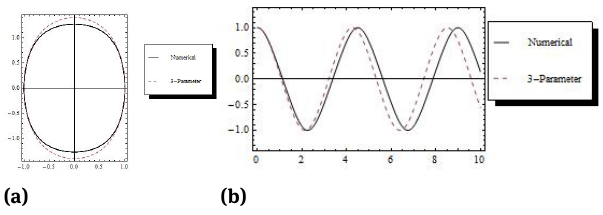
Fig. 2. (a) Comparison for the u versus ˙ u trajectory for the case of A = 1 (b) t versus u (displacement A = 1